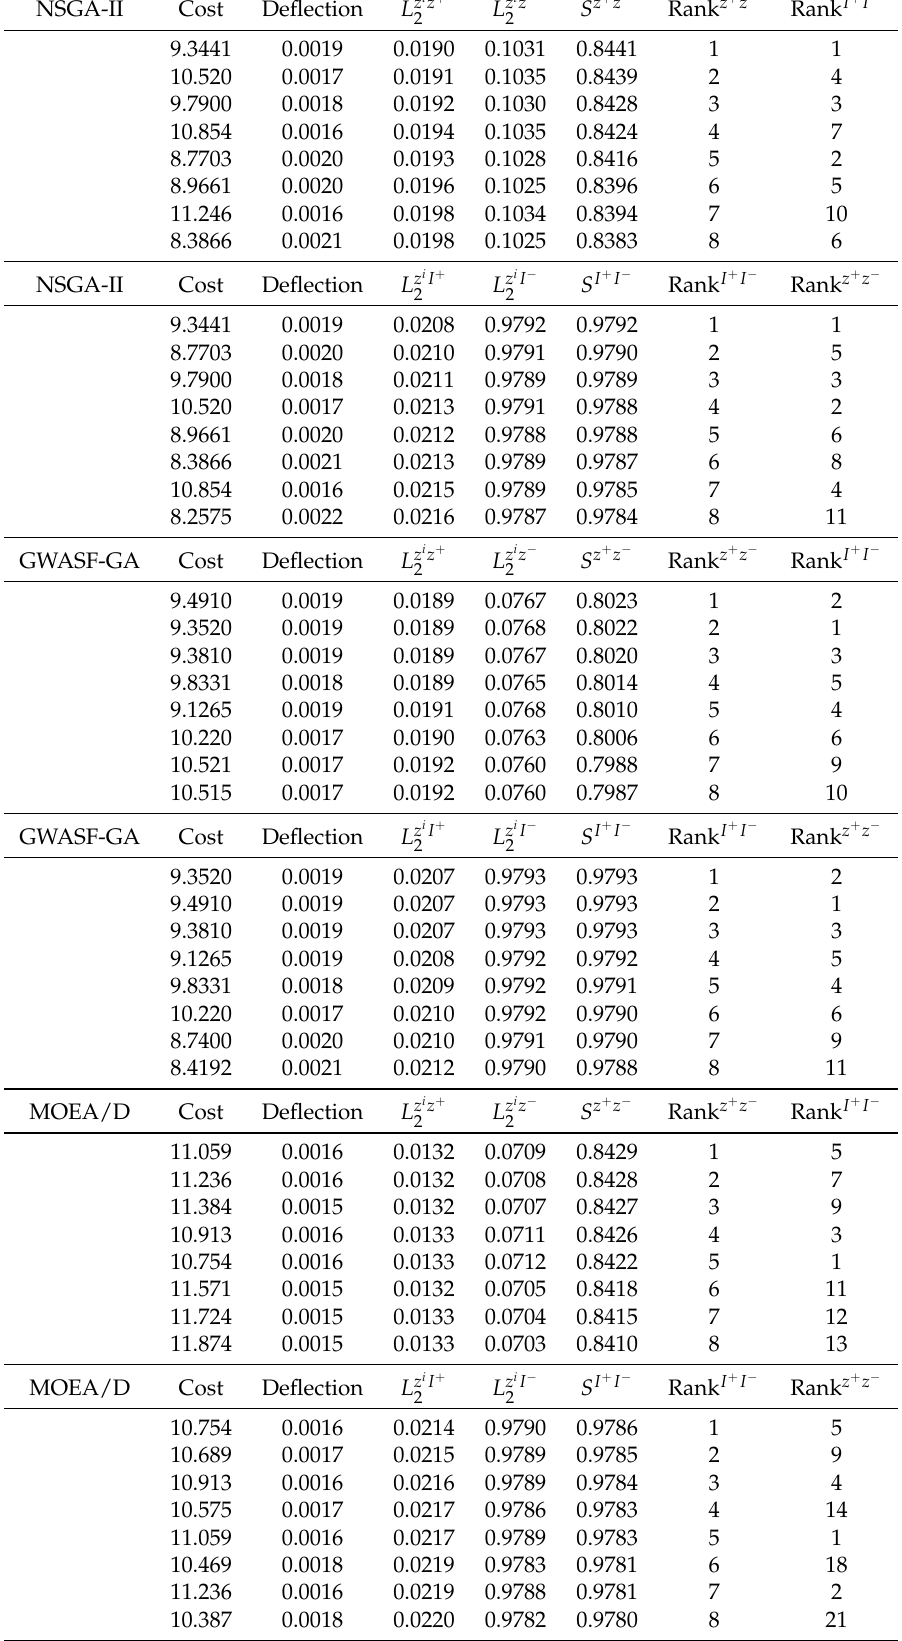
Table 5. TOPSIS ranking results with L 2 metric for NSGA-II, GWASF-GA and MOEA/D ( N = 100).